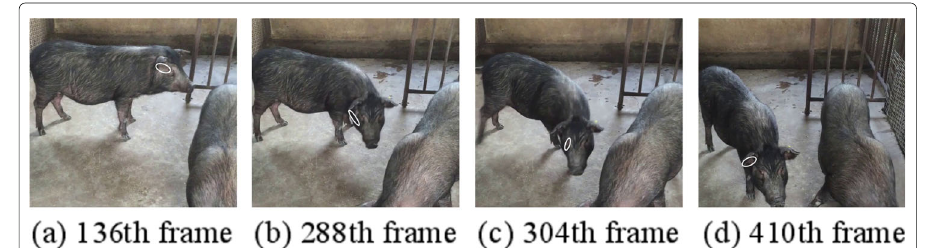
Fig. 4 Tracking results of the multi-feature fusion Camshift